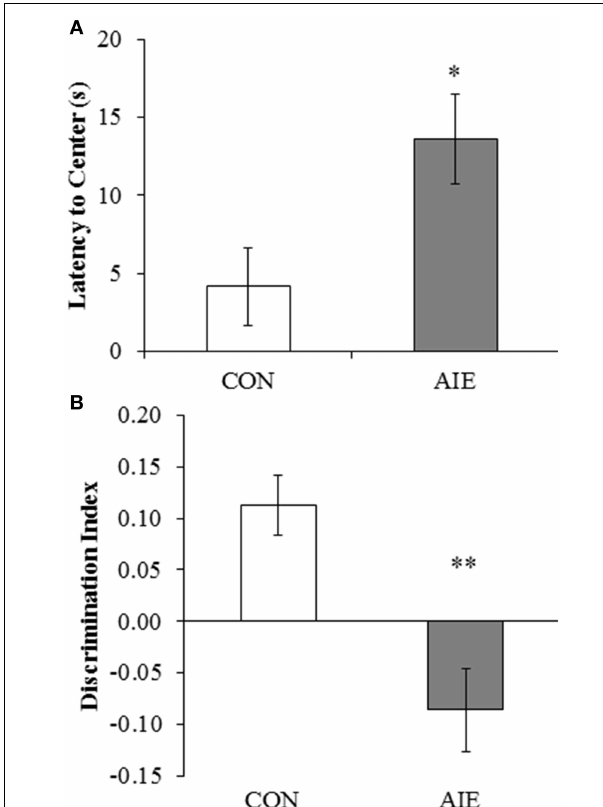
FIGURE 6 | Adolescent intermittent ethanol (AIE) treatment leads to long-term deficits in object recognition memory. (A) Latency to enter the center of the open-field apparatus during the first trial, which provides a measure of thigmotaxis, was significantly increased in adult rats following AIE treatment. (B) Adolescent intermittent ethanol treatment significantly reduced the discrimination index, which is indicative of impaired object recognition memory, in adult rats relative to CONs. Data are presented as mean ± SEM. ∗ indicates p < 0 . 05; ∗∗ indicates p < 0 . 01, relative to CON rats.